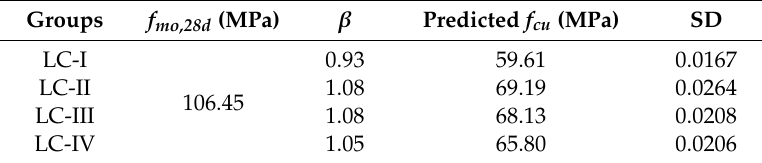
Table 7. The values of volumetric parameter and the estimated 28-day compressive